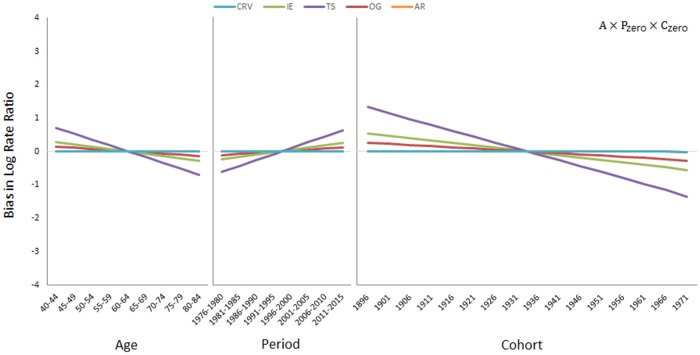
Simulation results when only the deterministic age effect is present (A×Pzero×Czero).